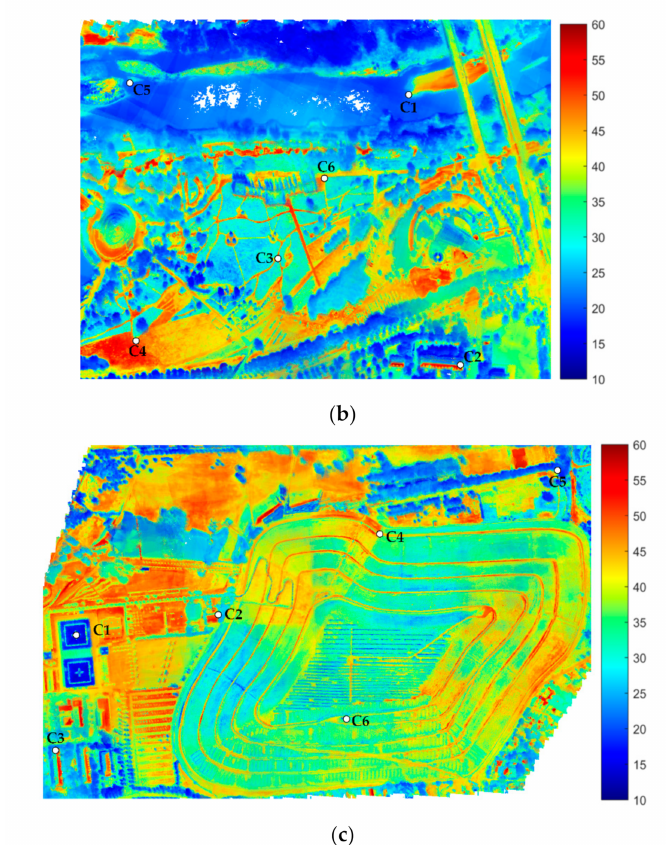
Figure 9. Thermal texture mapping results ( ◦ C) using strategy 3 for ( a ) building area, ( b ) river ecosystem, and ( c ) soil